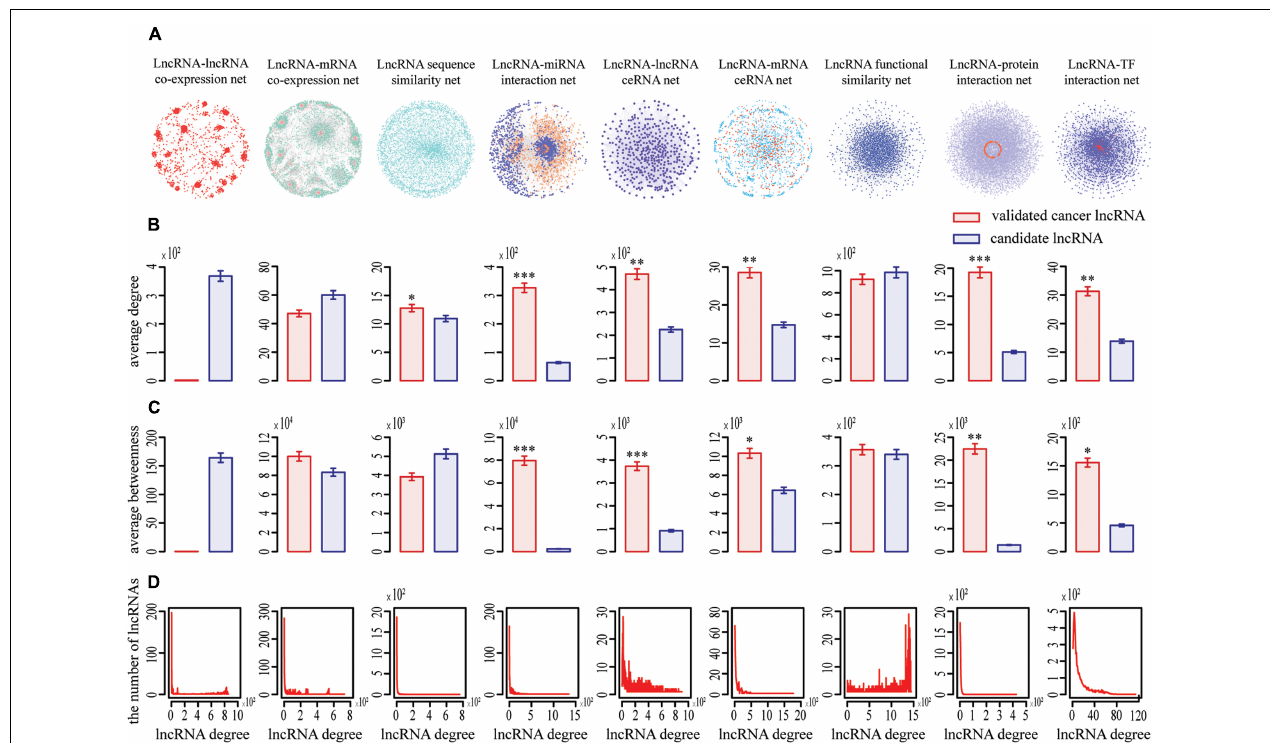
FIGURE 1 | Topological properties of nine lncRNA-centric networks involved in COAD. (A) Nine networks used to prioritize potential COAD-related lncRNAs. (B,C) Known cancer lncRNAs generally had significantly higher degree and betweenness centrality than other candidates in most networks based on Wilcox rank sum test (*, **, *** representing P < 0.05, P < 0.01, P < 0.001, respectively). Data were presented as means ± SEM. Known cancer lncRNAs and candidates are indicated in red and blue along the X axis, respectively. Average degrees of these two groups of lncRNAs are specified in the Y axis. (D) All networks displayed a power law distribution, except LFS (lncRNA function similarity network). The X axis indicates lncRNA degree distribution, Y axis indicates the number of lncRNAs according to the X axis.